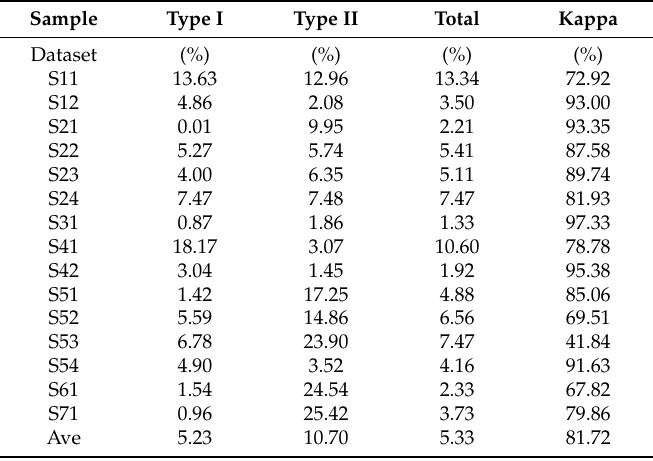
Table 1. Accuracy indexes for all sample